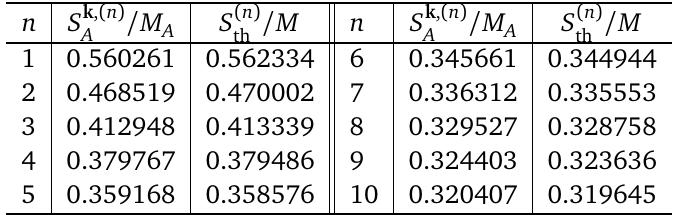
Table 1: Rényi entropies per unit of volume. The second column is the Rényi entropy per unit of volume computed for a 16 × 16 patch using the same system than in Fig. 1 and the random distribution (c). The third column is the thermal Rényi entropy per unit of volume evaluated using the fitted parameters of β and ¯ µ